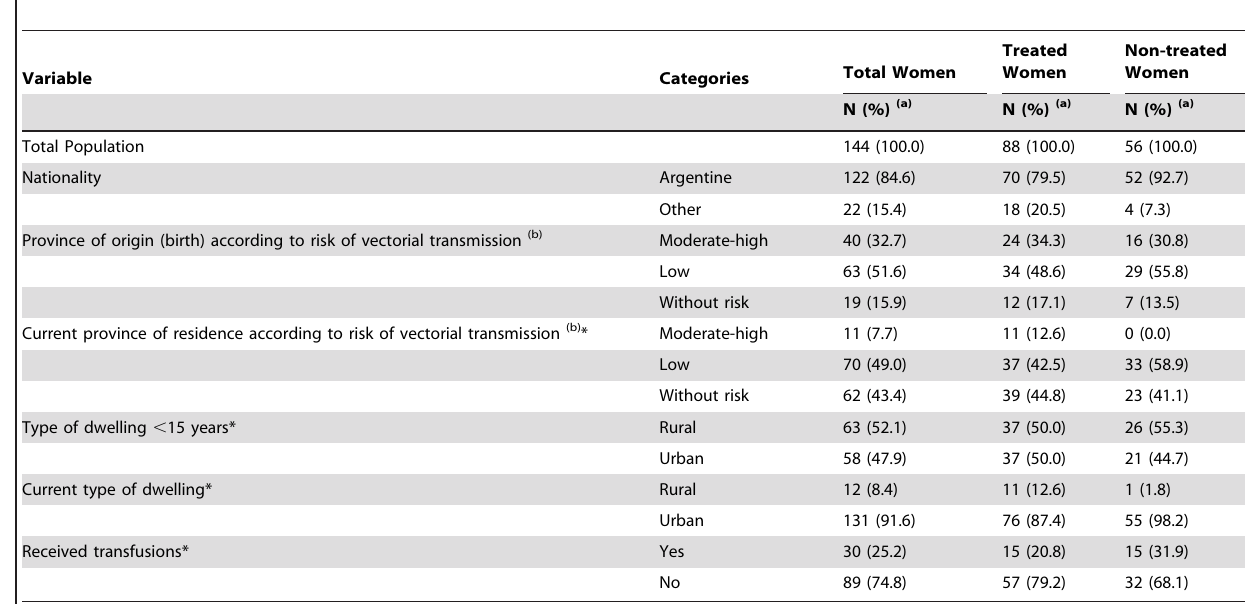
Table 1. Sociodemographic description and exposure of 144 women treated and untreated with trypanocidal drug.